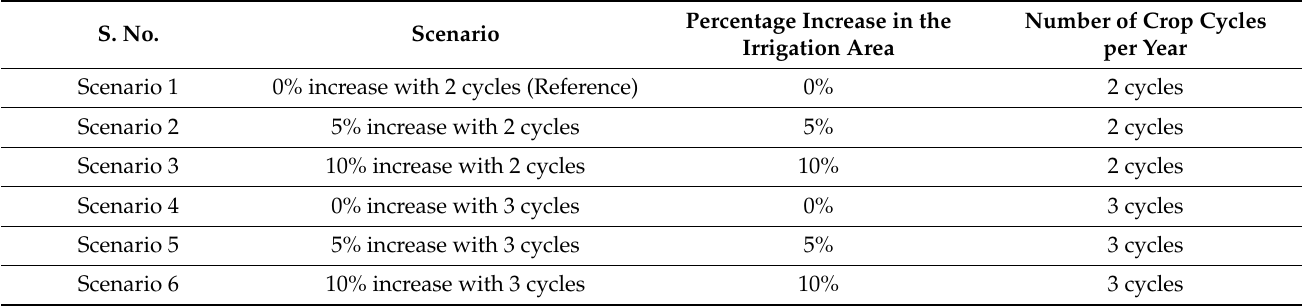
Table 2. Details of the scenarios considered to account for the increase in water demand by the irrigation sector based on irrigation area variation and crop cycle number per year. S. No.